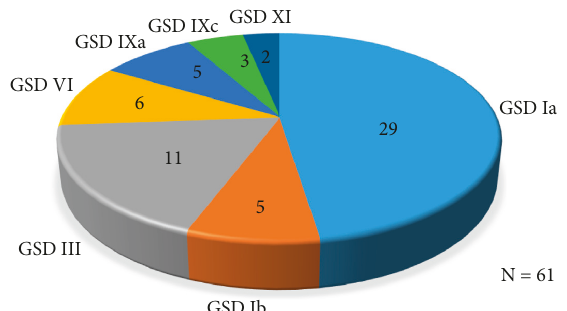
Figure 1: Number of patients diagnosed at the National Referral Centre, Genetic Clinic, Hospital Kuala Lumpur, Malaysia, from